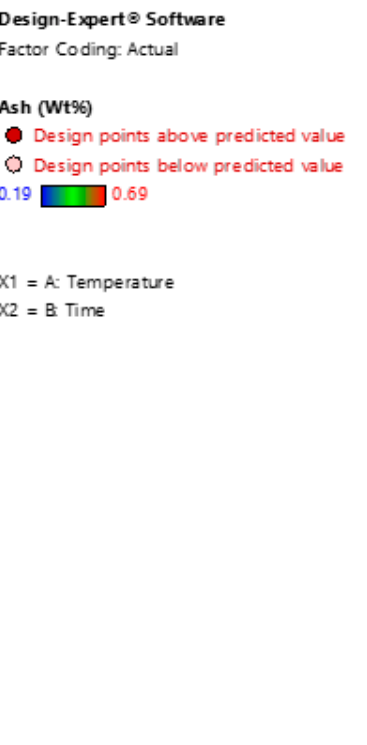
Figure 3. 3D response surface plot of the ash content considering the interactions of temperature and time.